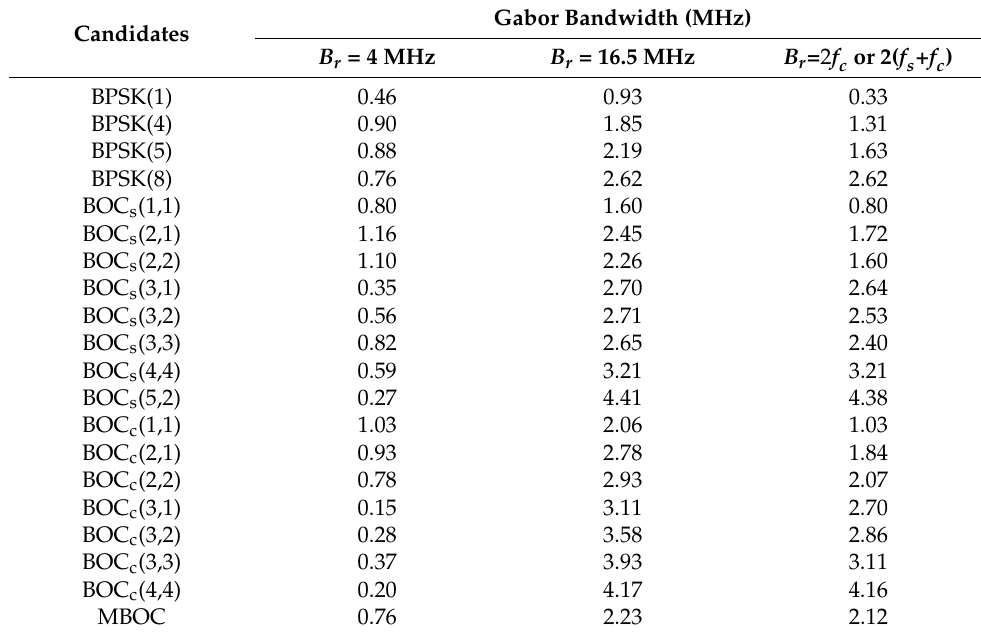
Table 8. Gabor bandwidths of the candidates in the